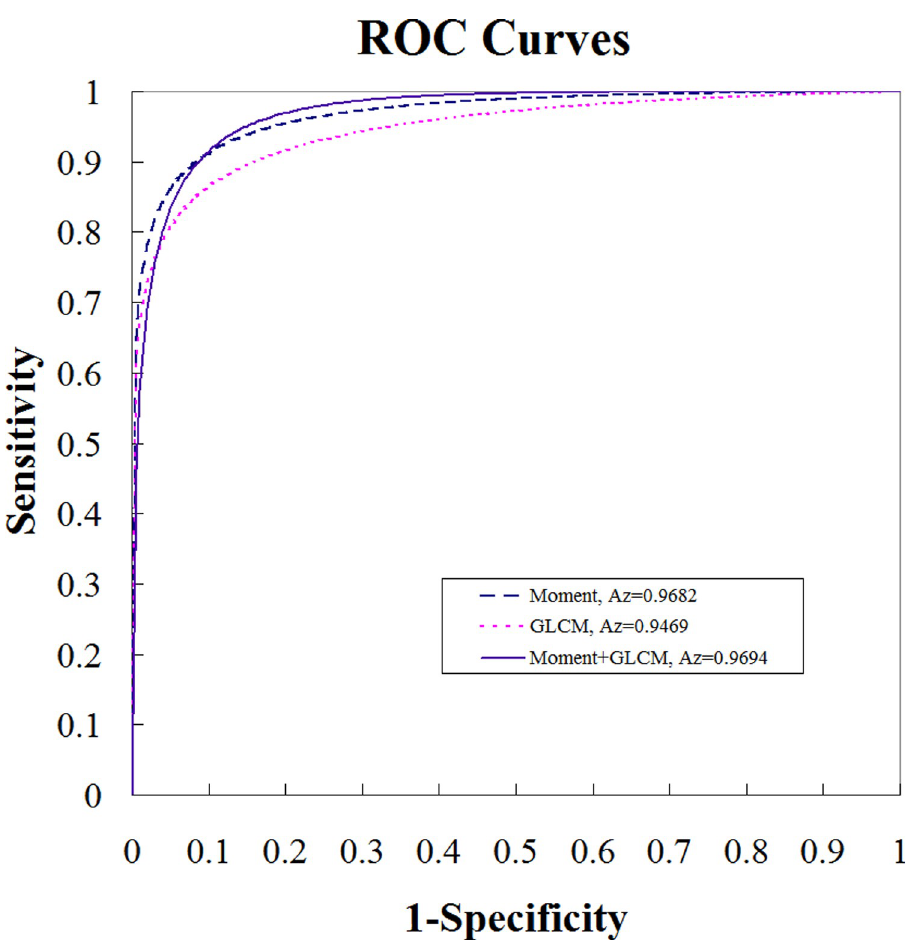
Fig 4. The trade-offs between the sensitivity and specificity of the computer-aided tear classification system using different feature sets are illustrated by receiver operating characteristic curves. (“Moment” is referred to intensity model; “GLCM” is referred to texture model; and “Moment + GLCM” is referred to a combined